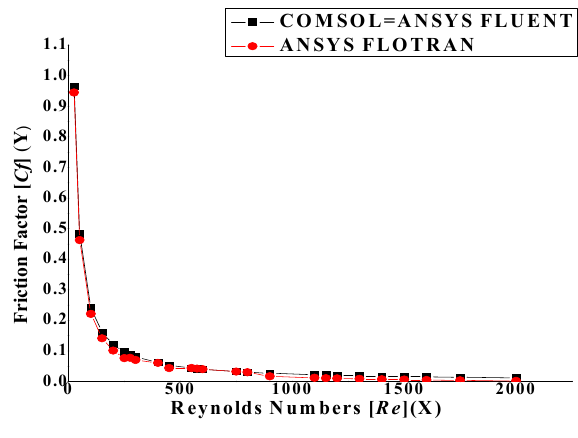
Figure 6. Friction factor for Dh = 0.5 mm.